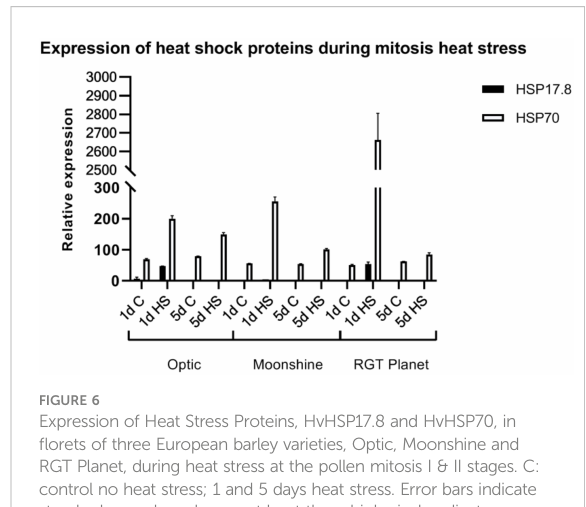
FIGURE 6 Expression of Heat Stress Proteins, HvHSP17.8 and HvHSP70, in fl orets of three European barley varieties, Optic, Moonshine and RGT Planet, during heat stress at the pollen mitosis I & II stages. C: control no heat stress; 1 and 5 days heat stress. Error bars indicate standard error, based upon at least three biological